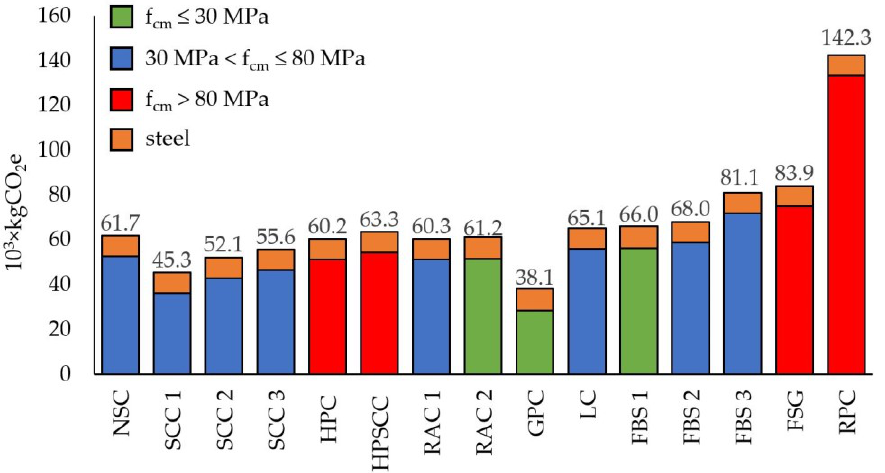
Figure 11. Carbon footprint value over the entire life cycle for concrete and reinforcing steel in the analyzed structure.